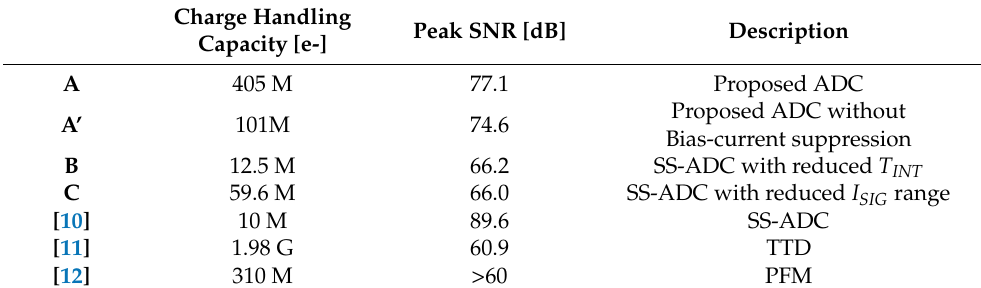
Table 2. Performance comparison.